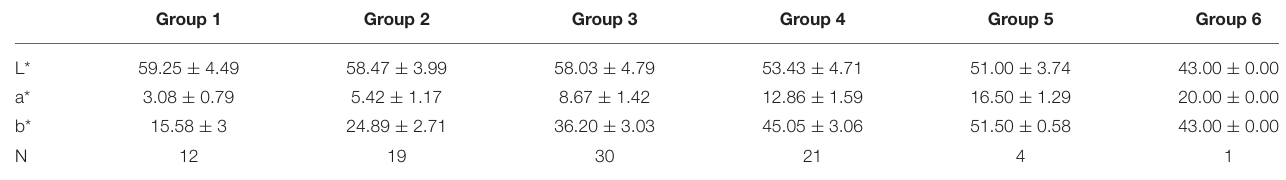
TABLE 3 | Grouping results of urine samples with normal urine dry chemical parameters ( n = 87).